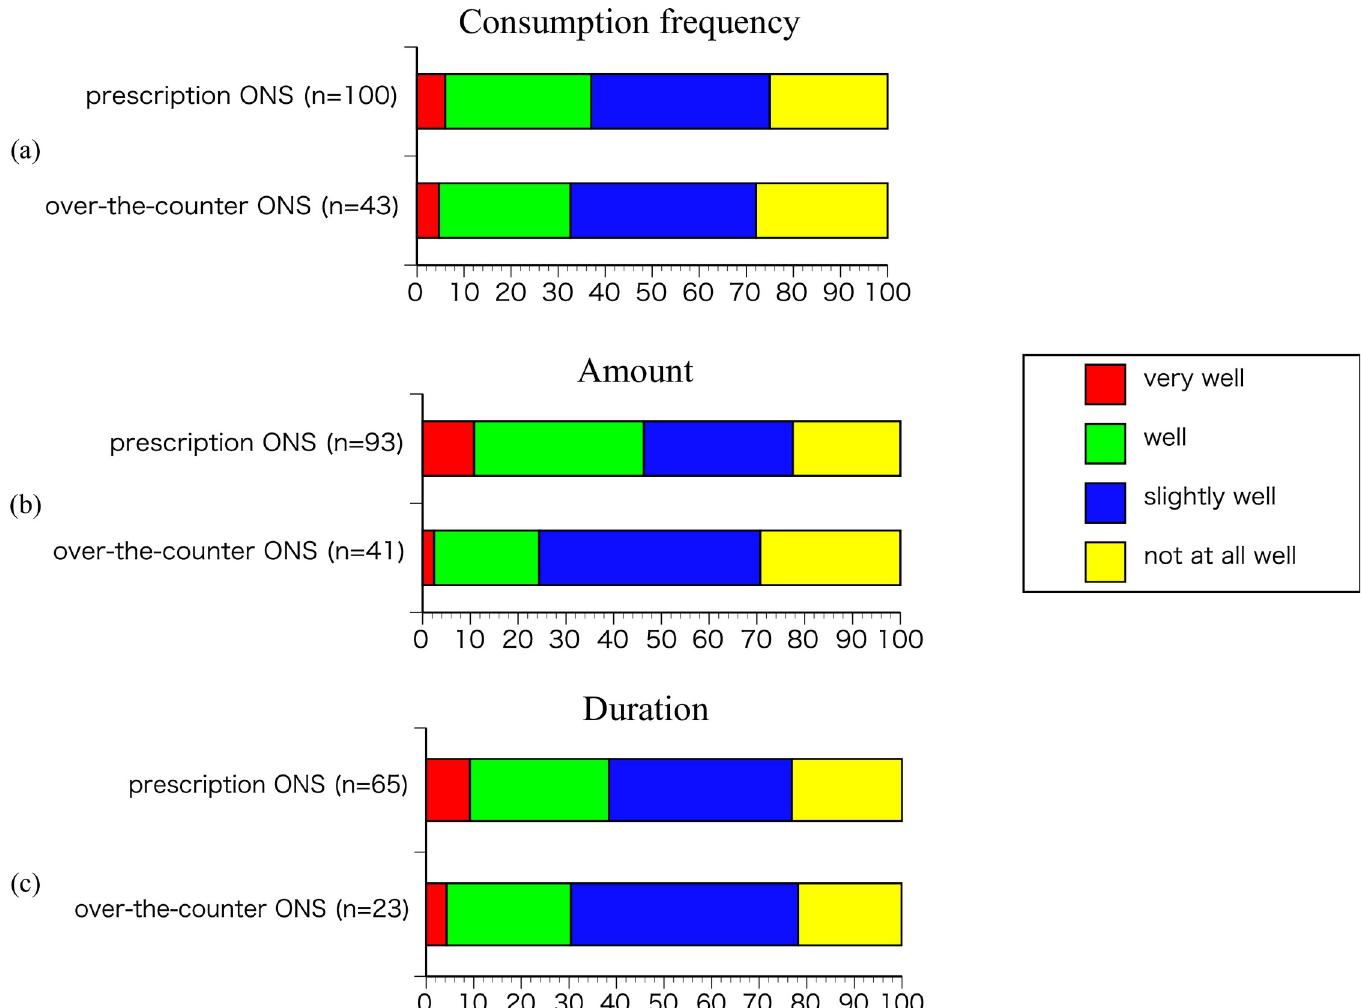
Fig 5. Adherence to medical advice on taking ONS. (a); Consumption frequency in the prescription ONS group (n = 100) and over-the-counter ONS group (n = 43). (b) Amount in the prescription ONS group (n = 93) and over-the-counter ONS group (n = 41). (c); Duration in the prescription ONS group (n = 65) and over-the-counter ONS group (n =